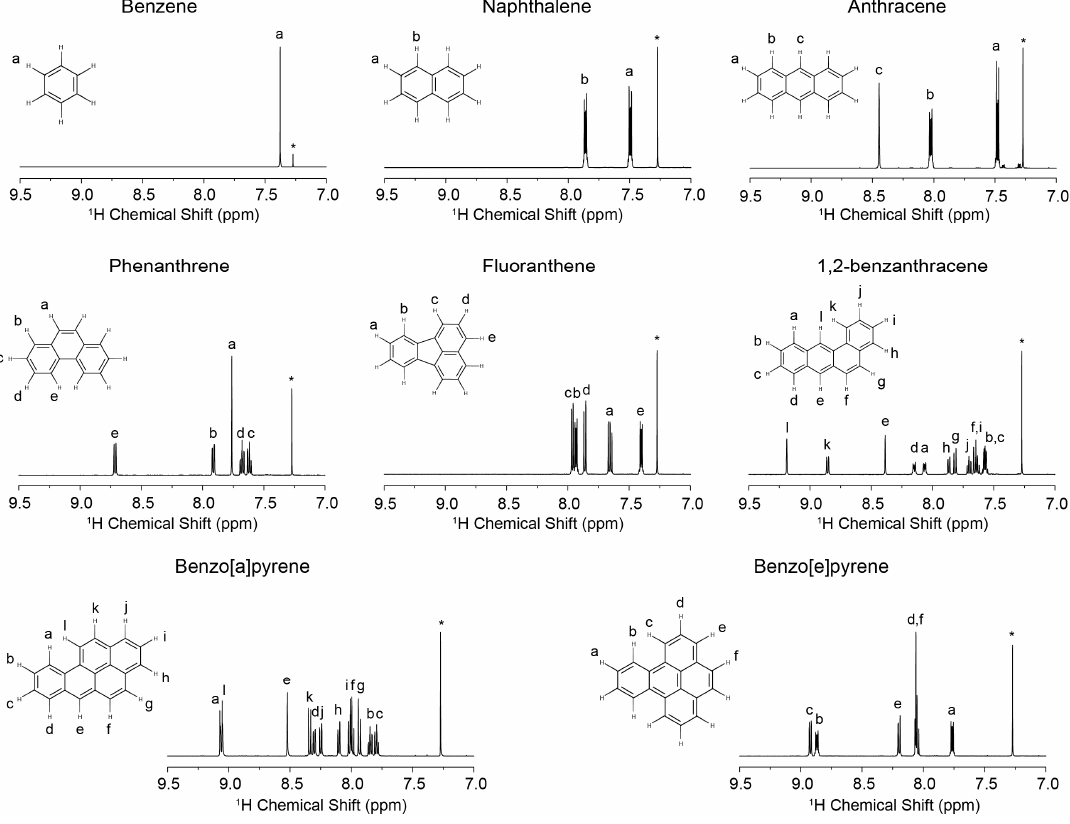
Figure 1. 1 H nuclear magnetic resonance (NMR) spectra and peak assignments in Deuterated chloroform (CDCl 3 ) of benzene, fluoranthene, 1,2-benzanthracene, benzo[e]pyrene, benzo[a]pyrene, anthracene, naphthalene, and phenanthrene. * represent CDCl 3 peak.